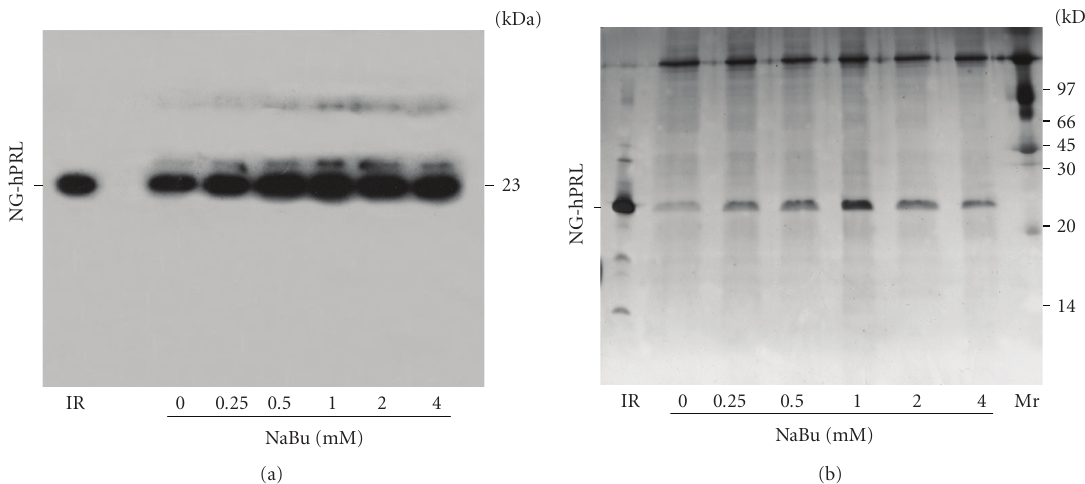
Figure 5: (a) Western blot analysis and (b) SDS-PAGE stained with AgNO 3 of 10-day production pools of hPRL secreted by CHO cells treated with di ff erent NaBu concentrations. IR: Internal Reference of periplasmic E. coli- derived hPRL. Mr: molecular mass marker.